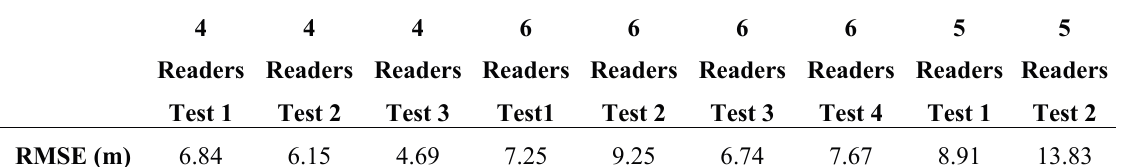
Table 5. RMSE of Kriging interpolation on RFID